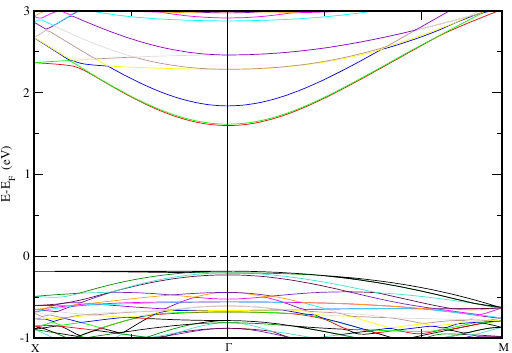
Figure 4. Electronic band structure of Cubic STO with vacuum along c-axis. High symmetry points are X(0.5,0,0)- Γ (0,0,0)-M(0.5,0.5,0.0) and the horizontal dashed line implies the E f set to zero energy at Y-axis.